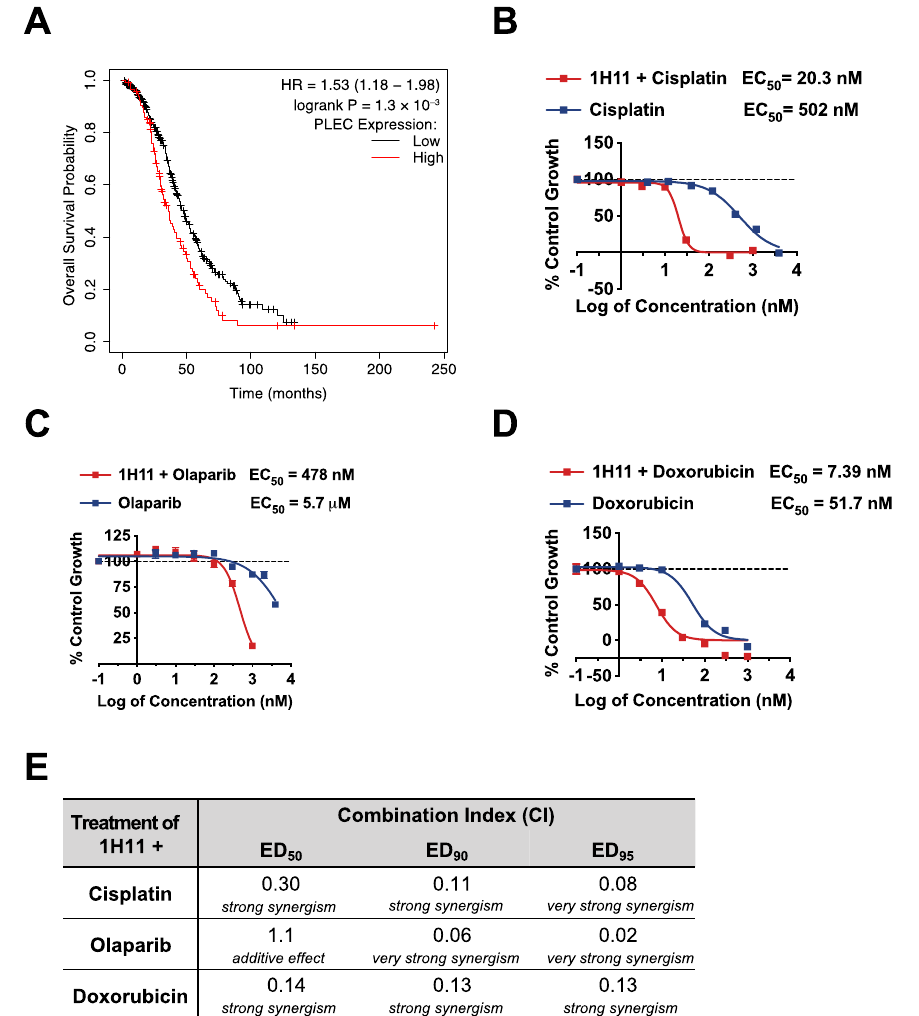
Figure 8. 1H11 increases potency of first-line OC therapies in vitro. ( A ) A patient survival analysis using the KM plotter database revealed that in serous mutant TP53 OC patients who received platinum-based chemotherapy, higher plectin mRNA expression is significantly associated with worse overall survival. ( B – D ) OVCAR8 cell viability was evaluated by SRB assay. Results demonstrate that dual treatment with 1H11 increases the potency of ( B ) cisplatin, ( C ) olaparib, and ( D ) doxorubicin. All data plotted as mean ± SEM. ( E ) The combination index (CI) values of combinational treatment with 1H11 and different anticancer agents on OVCAR8 cells. The interpretation of CI values is listed below.